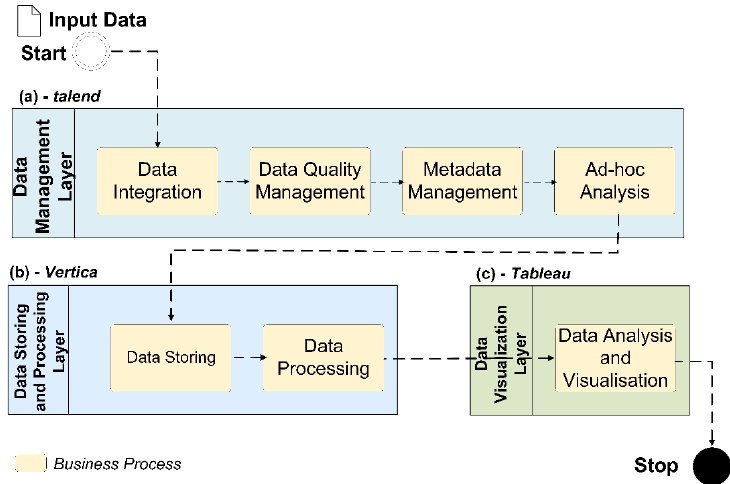
Figure 2. Business process organisation and tests data flow.